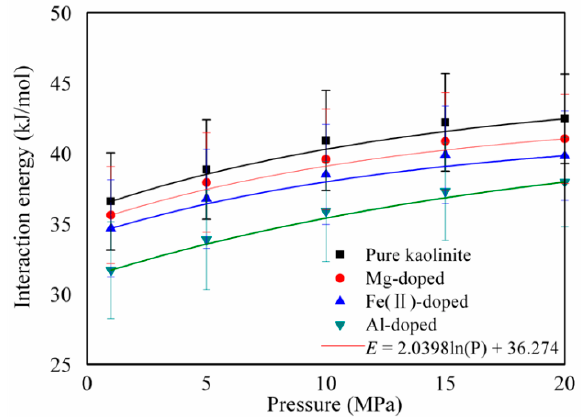
Figure 4. Interaction energies of CH 4 adsorption on pure and Mg-, Fe(II)-, and Al-doped kaolinite at different pressures. Error bars indicate the standard deviations.